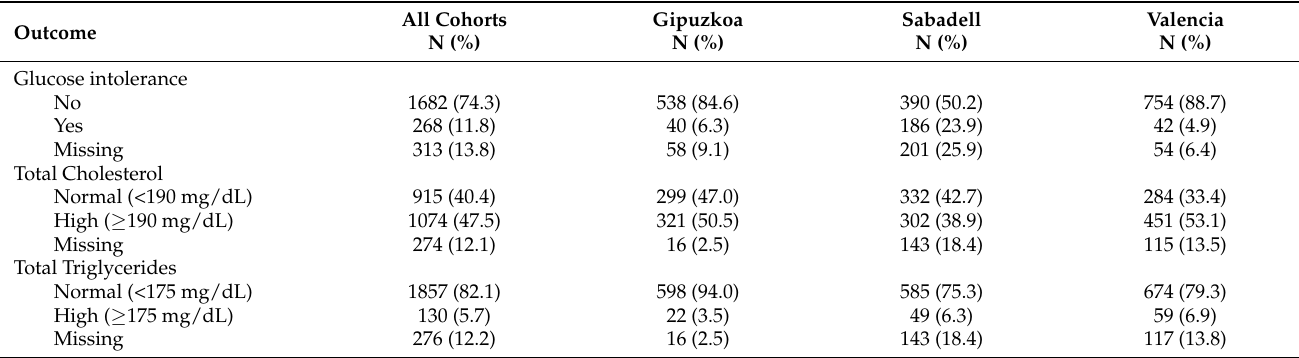
Table 2. Prevalence of glucose intolerance (IGT/GDM) and elevated serum lipids among women of the INMA Cohort, 2003–2008.